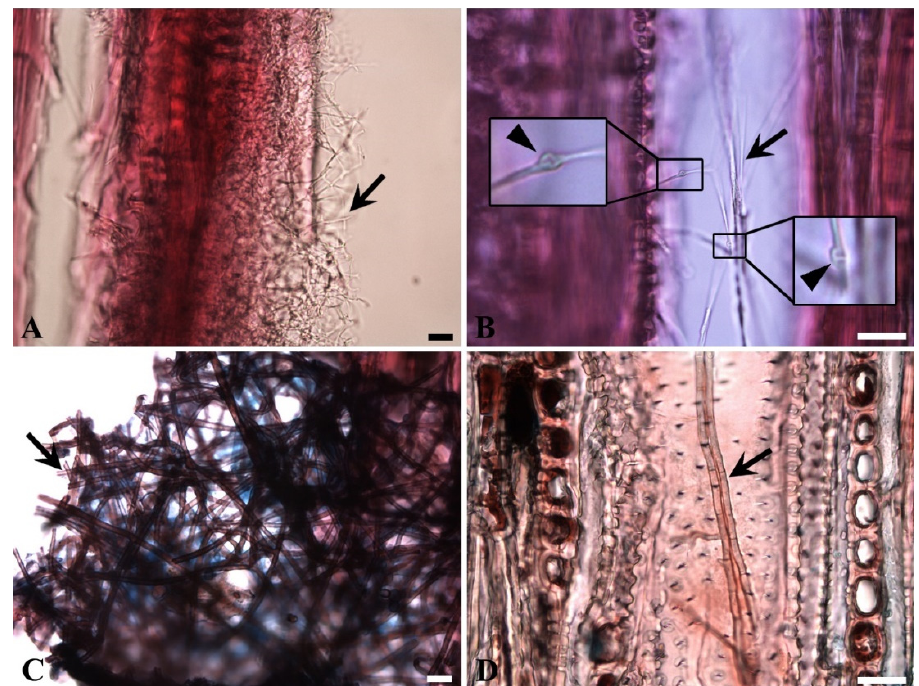
Figure 6. Morphology of fungal hyphae of P. ostreatus found in decayed beech and oak wood ( A ) and ( B ) fungal hyphae in beech were thin (arrow in A ) with clamp connections (arrowheads in insets of B ). ( C , D ) Fungal hyphae in oak were much thicker than that in beech ( A , B ). No clamp connections were noted ( D ) Scale bars: 30 µm.